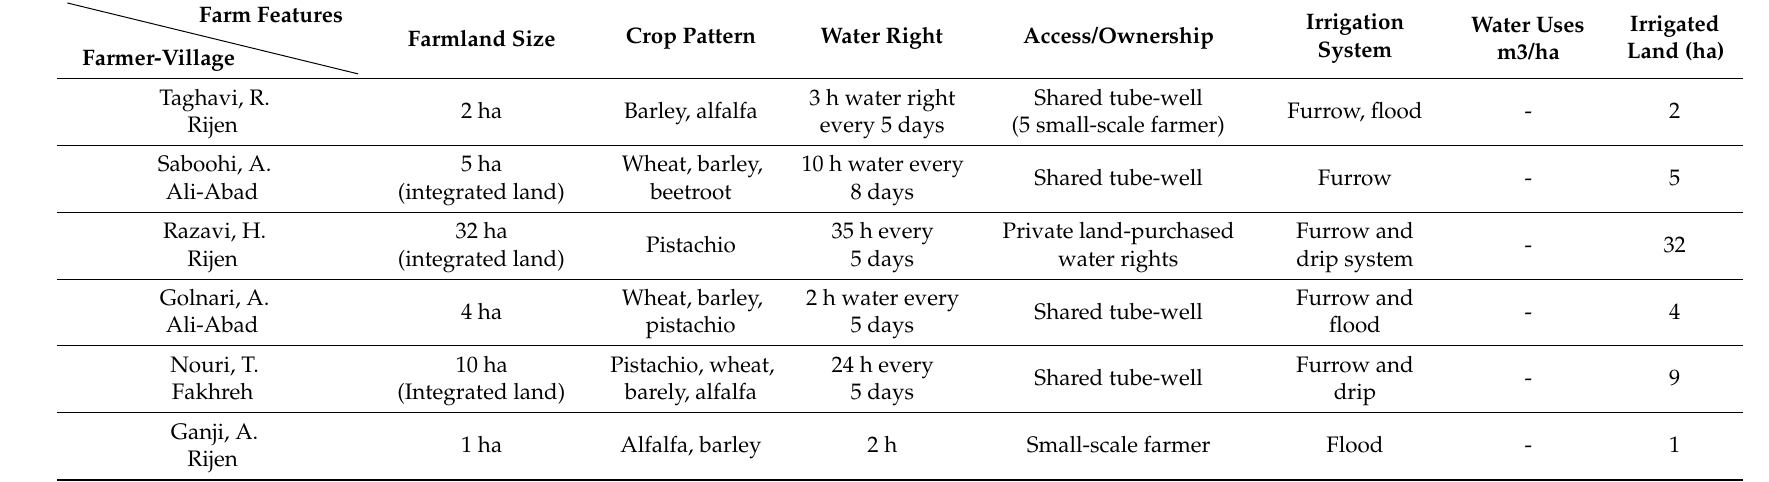
Table 2. An example of surveyed local farmers in Kashan